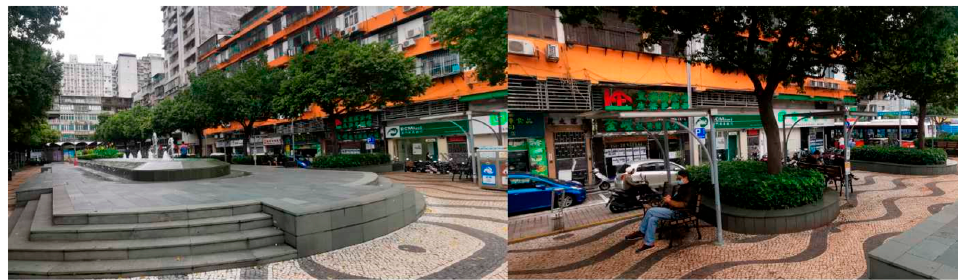
Figure 13. Praça de Ponte e Horta.